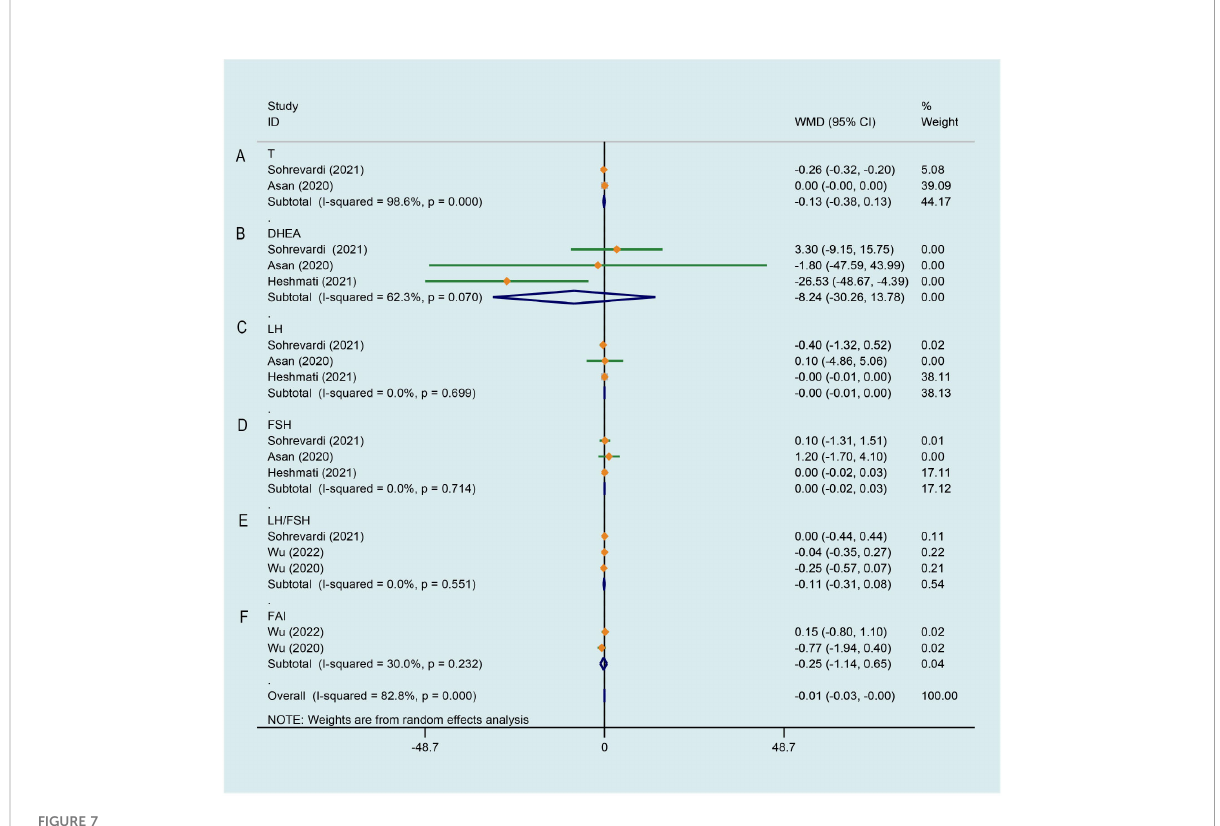
FIGURE 7 Meta-analyses of the effect of curcumin on hormone parameters. (A) T, (B) DHEA, (C) LH, (D) FSH, (E) LH/FSH, (F)